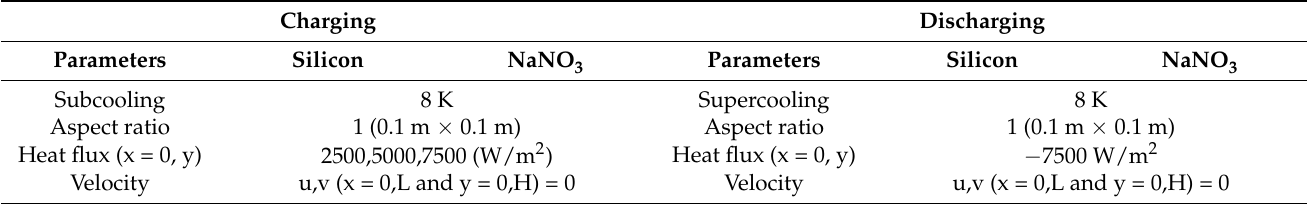
Table 2. Fixed parameters for both